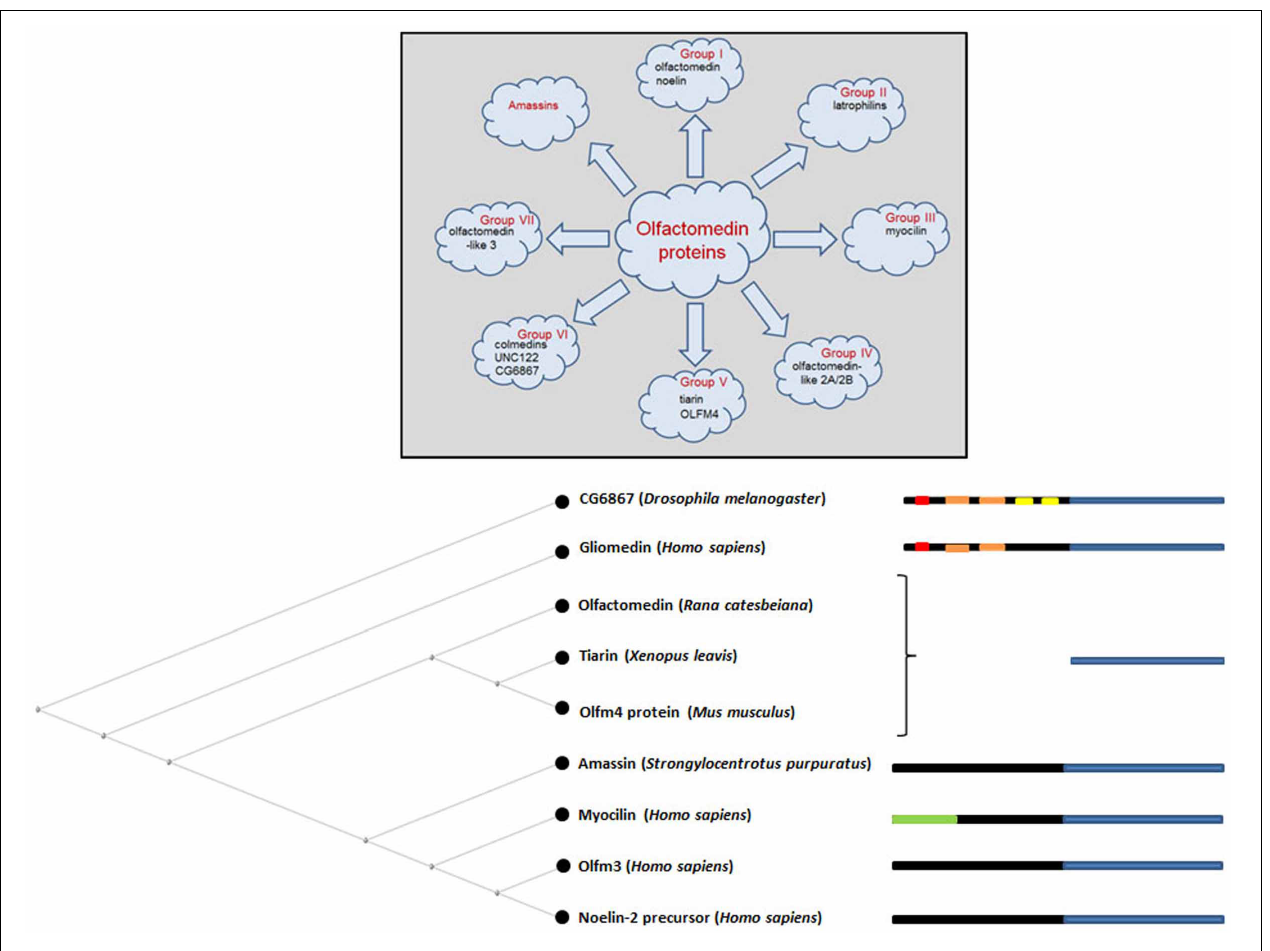
FIGURE 2 | Overview of the olfactomedin protein family. The upper diagram highlights examples of olfactomedin proteins in each category focusing on proteins that are described in this review. The lower diagram shows a neighbor joining tree for some representative members of the family with diagrammatic representations of protein domains, indicating the olfactomedin homology domain in blue,